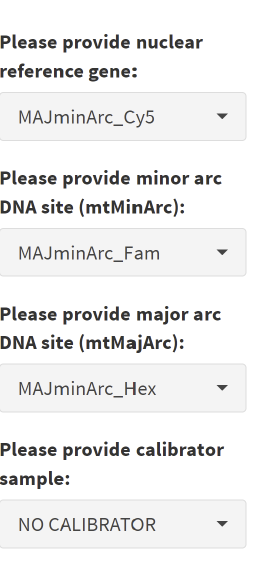
Figure 3. Analysis settings for mtDNA assessment.